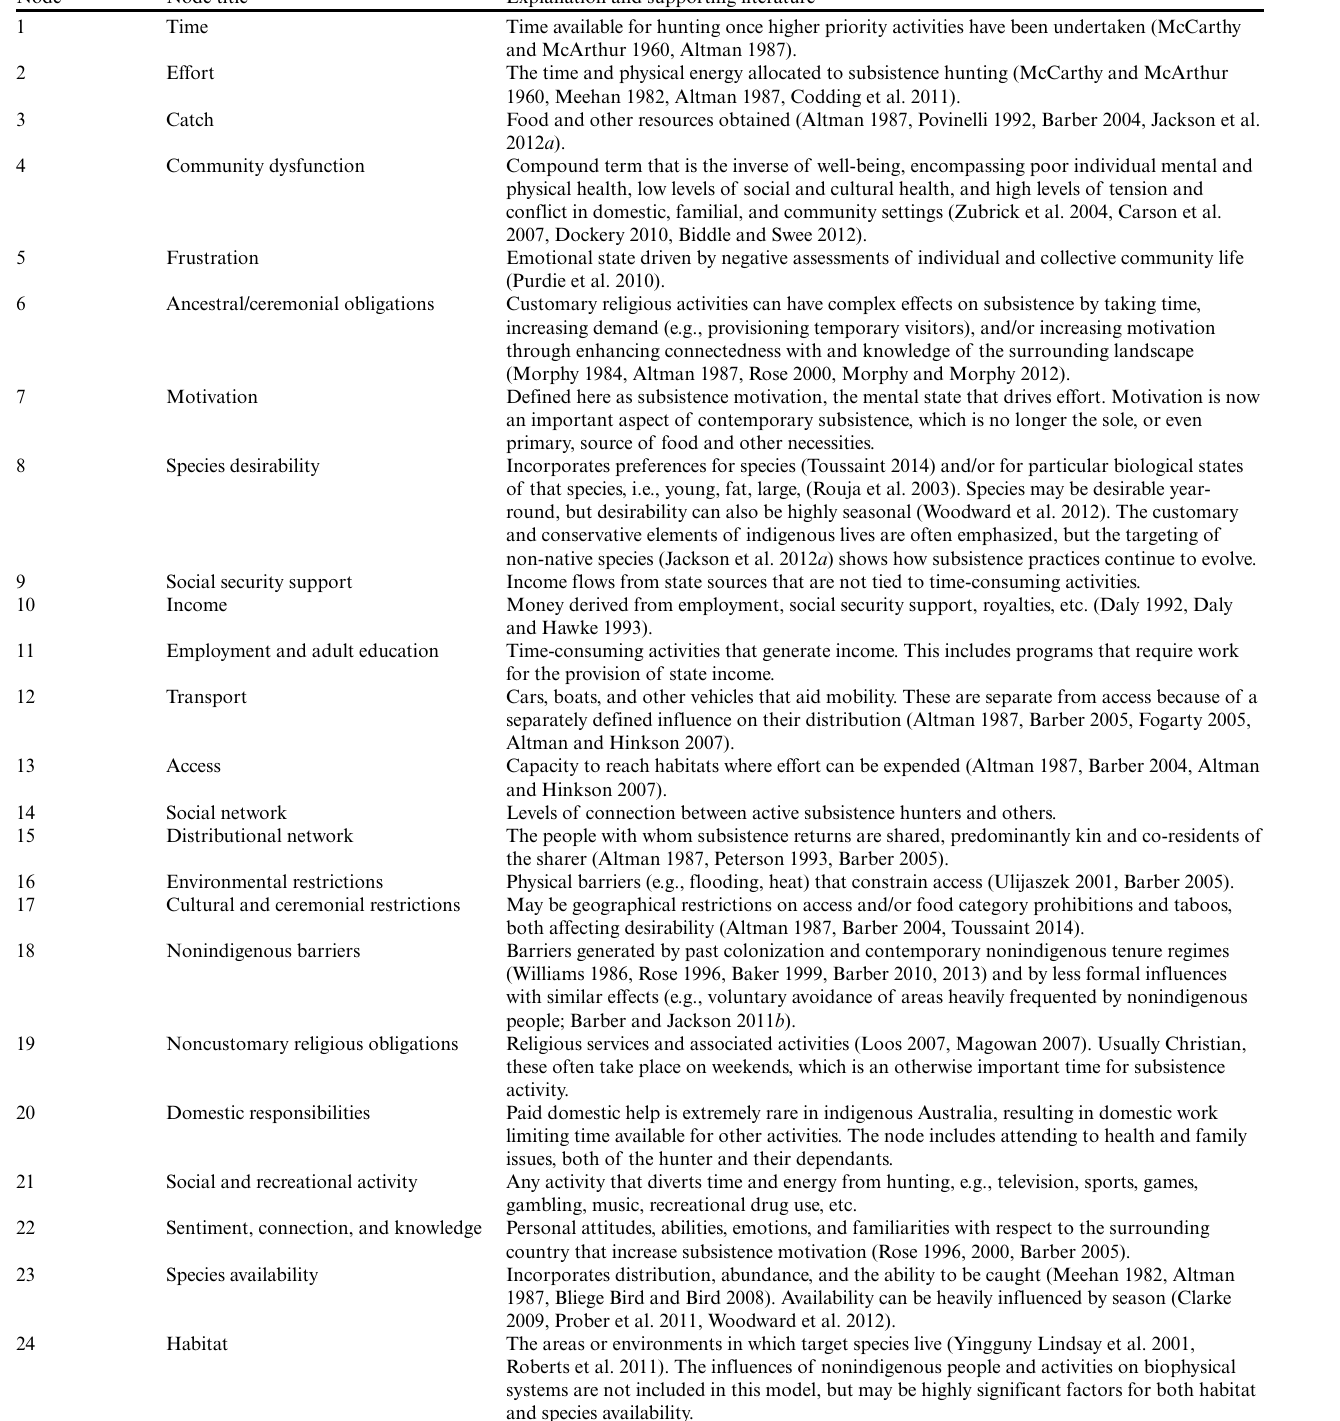
Table 3. Definition of nodes in model